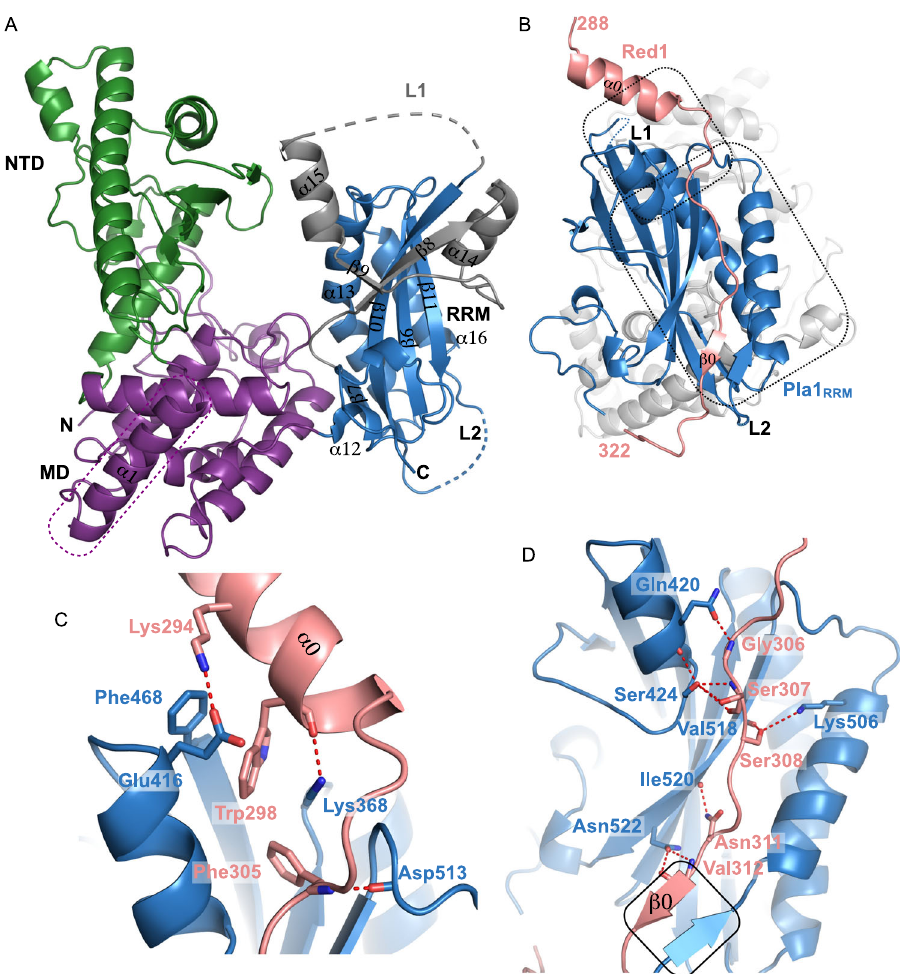
Fig. 2 | Crystal structures of Pla1 in its apo form and in complex with Red1. A The overall architecture of Pla1 in its apo form is shown. Colour scheme for Pla1 domains are the same as Fig. 1A. The N- and C-termini of the protein and loops L1 (shown in grey) and L2 of RRM domain are marked. The Pla1 N-terminal α 1, which formsapartoftheMD,isboxedinpurple.Thesecondarystructureelementsofthe RRMdomaincomprisinghelices α 12- α 16and β -strands β 6- β 11aremarked. B Crystal structure of Pla1-Red1 complex. Red1 and Pla1 RRM are shown in salmon and blue,